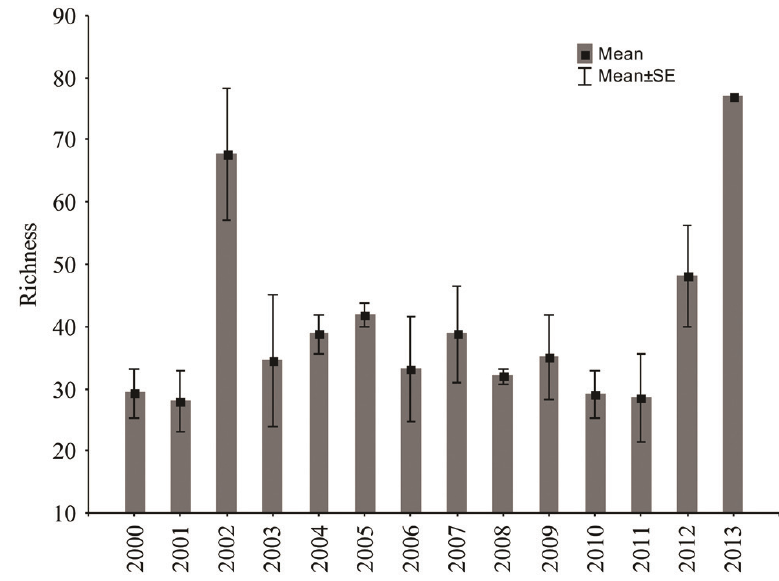
Figure 5. Interannual variability of mean values of phytoplankton richness in the floodplain lake.